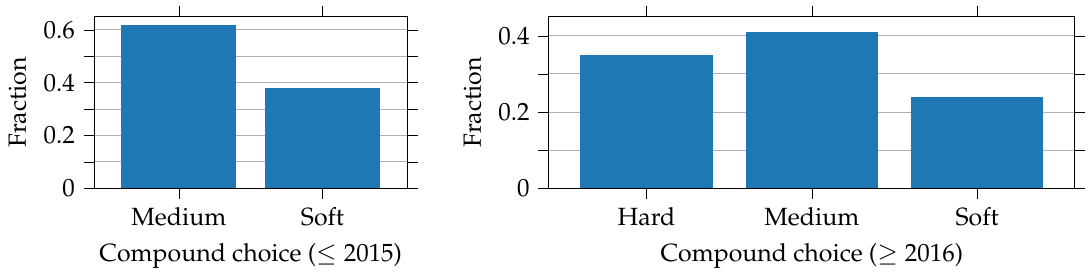
Figure 5. Fractions of compounds chosen during pit stops in the 2014 and 2015 seasons ( left ) and from the 2016 season onwards ( right ). The distributions shown represent the situation after filtering the data according to Section